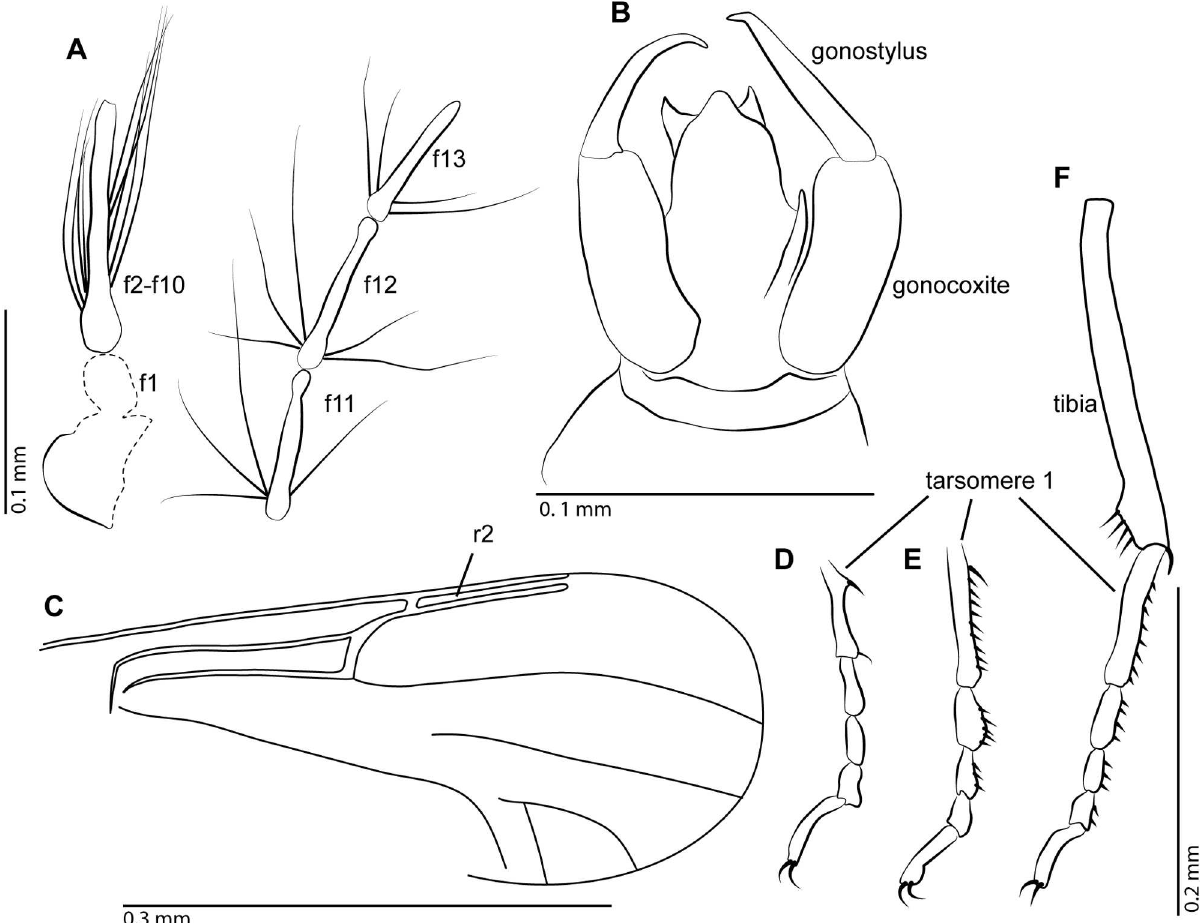
Fig 8. Meunierohelea orientalis n. sp. from early Eocene Cambay amber, holotype male, no. Tad-858a. A . Antenna, pediceland flagellomeres(f1-f13). B . Genitalia,ventral view. C . Wing. D . Tarsus of fore leg. E . Tarsus of mid leg. F . Tibia and tarsus of hind leg.